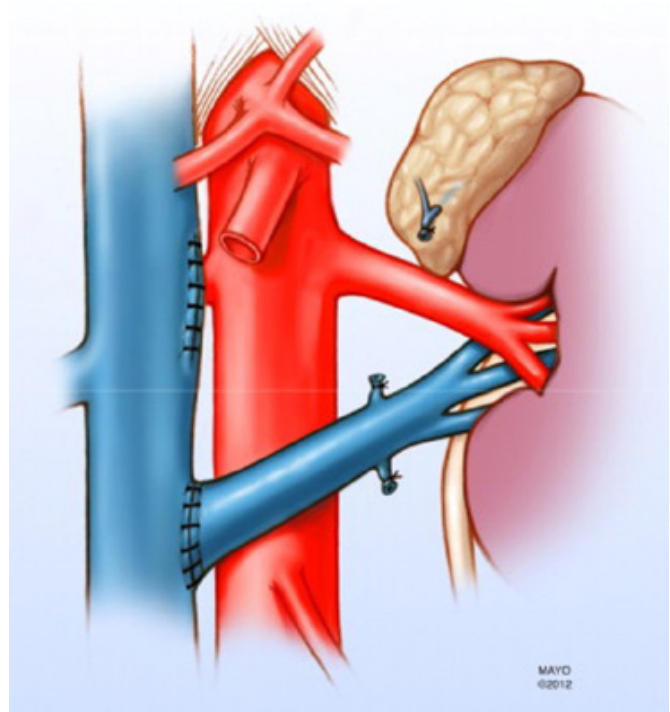
Figure 2. Illustration demonstrating representative surgical correc- tion of compressed left renal vein in anterior Nutcracker syn- drome. Reproduced from open access journal reference